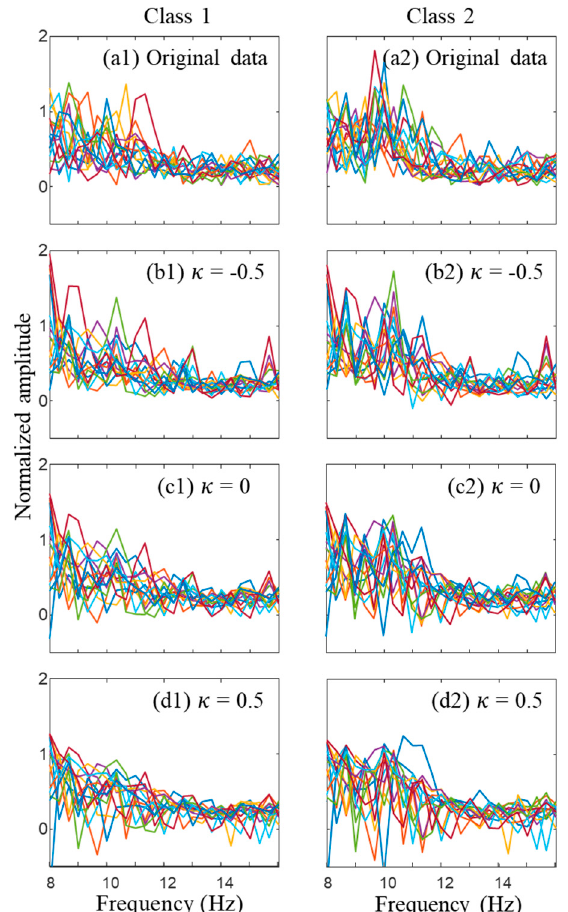
Figure 6. Artificial data generated with GNDvw2. The y -axis represents the normalized amplitude in the frequency domain.